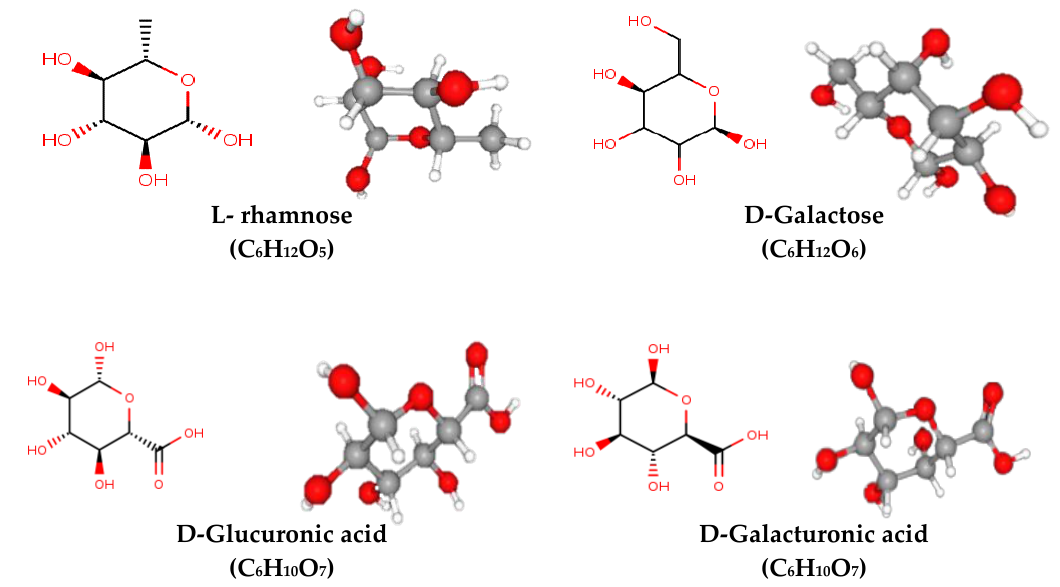
Figure 2. Chemical structure of different mucilage (L- rhamnose (C 6 H 12 O 5 ) 6-deoxy-hexose or methyl-pentose, D-Galactose (C 6 H 12 O 6 ) C-4 epimer of glucose, D-Glucuronic acid (C 6 H 10 O 7 ) sixth carbon atom oxidized to a carboxylic acid, D- Glucuronic acid (C 6 H 10 O 7 ) an aldehyde group at C1 and a carboxylic acid group at C6).